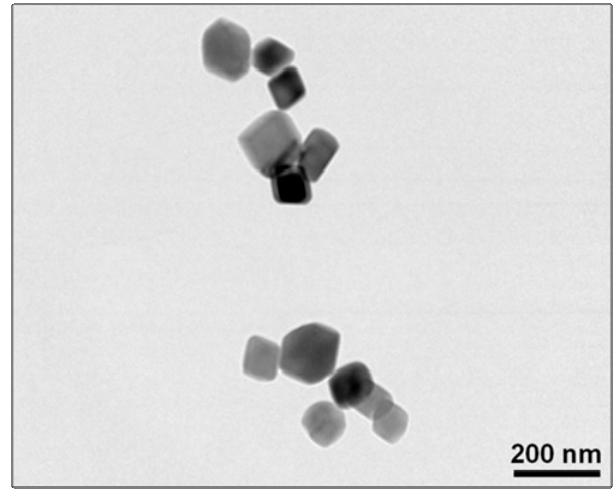
Figure 2. A bright-field transmission electron microscopy image of the non-coated CaCO 3 rhombohedral nanoparticles.